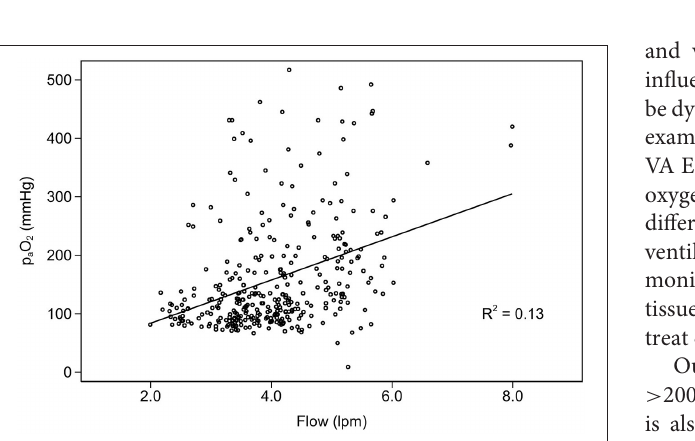
FIGURE 5 | Interaction between ECMO blood flow rate and partial pressure of